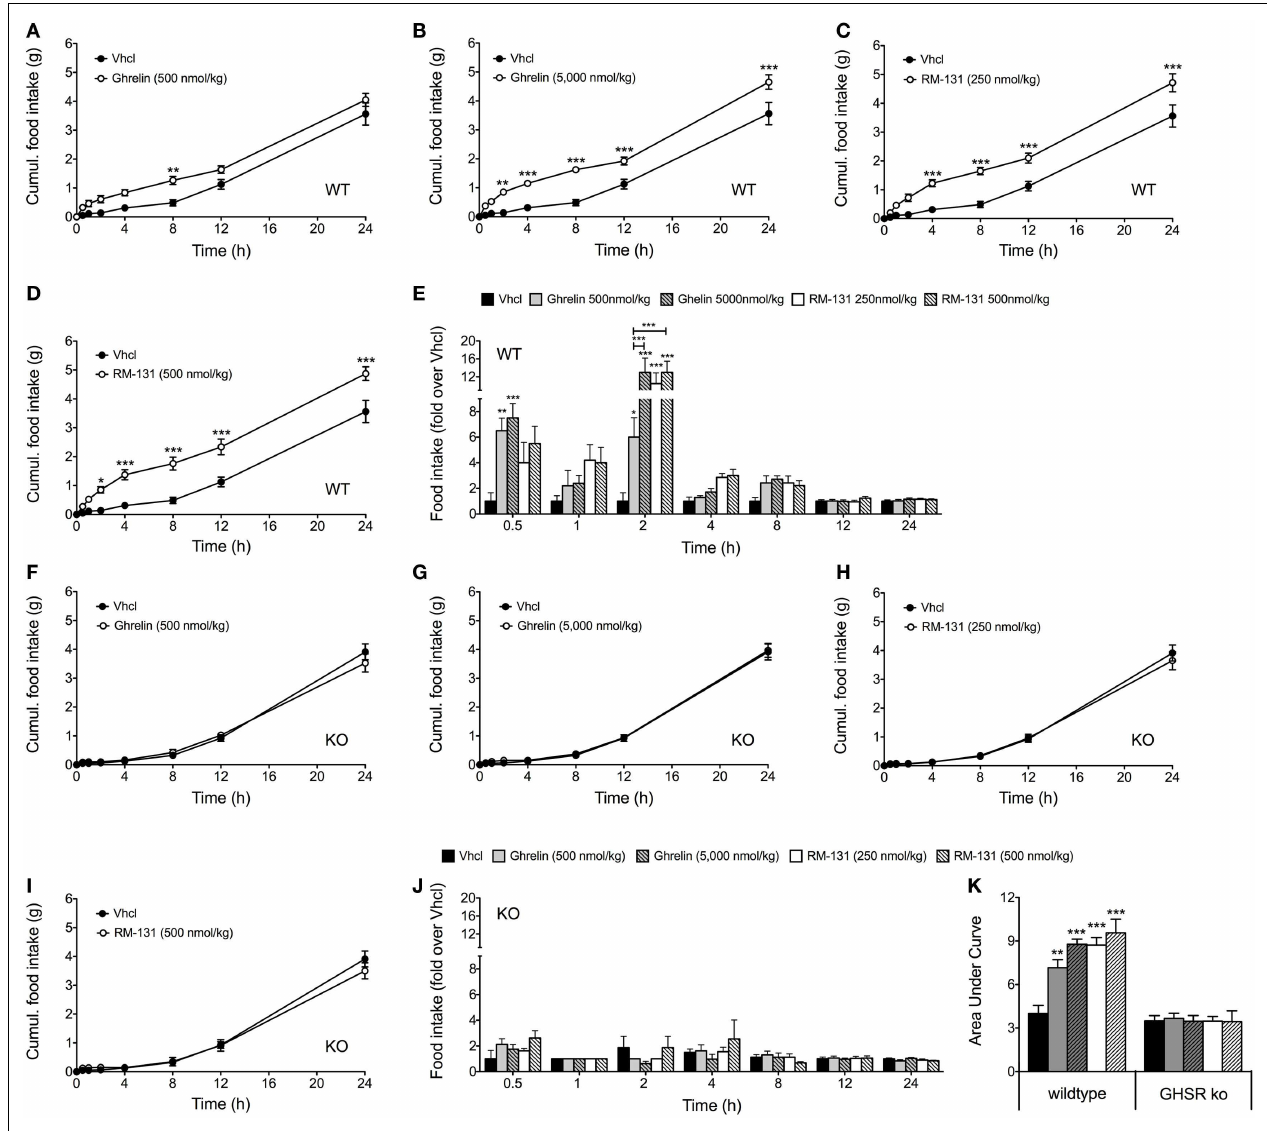
fold-increase in food intake relative to mice treated with vehicle (E,J) , and area under curve of the 24-h food intake (K) . N = 8 mice each genotype and treatment group. Data represent means ± SEM. Asterisks indicate * p < 0.05; ** p < 0.01; *** p < 0.001.